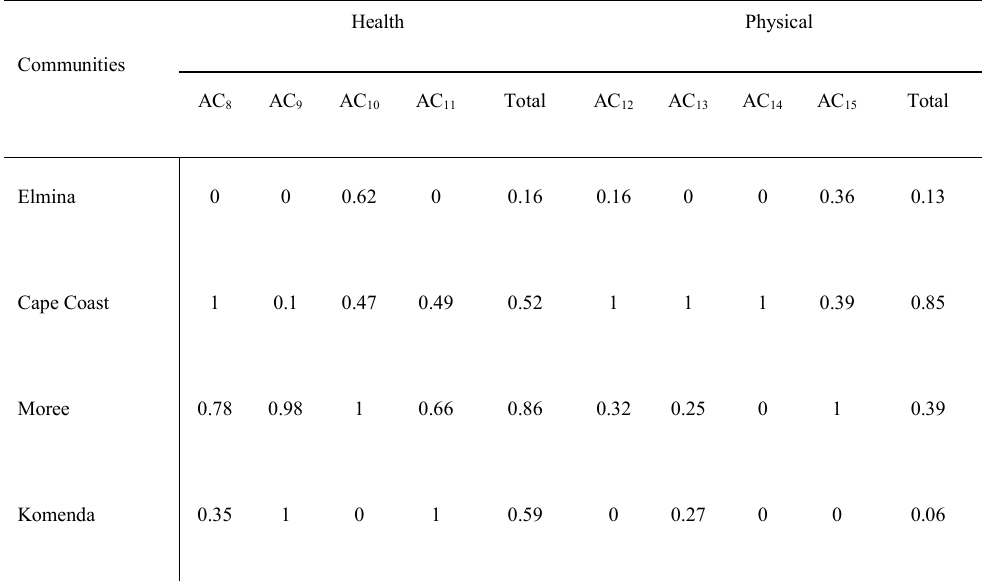
Table 5: Score of adaptation using health and physical